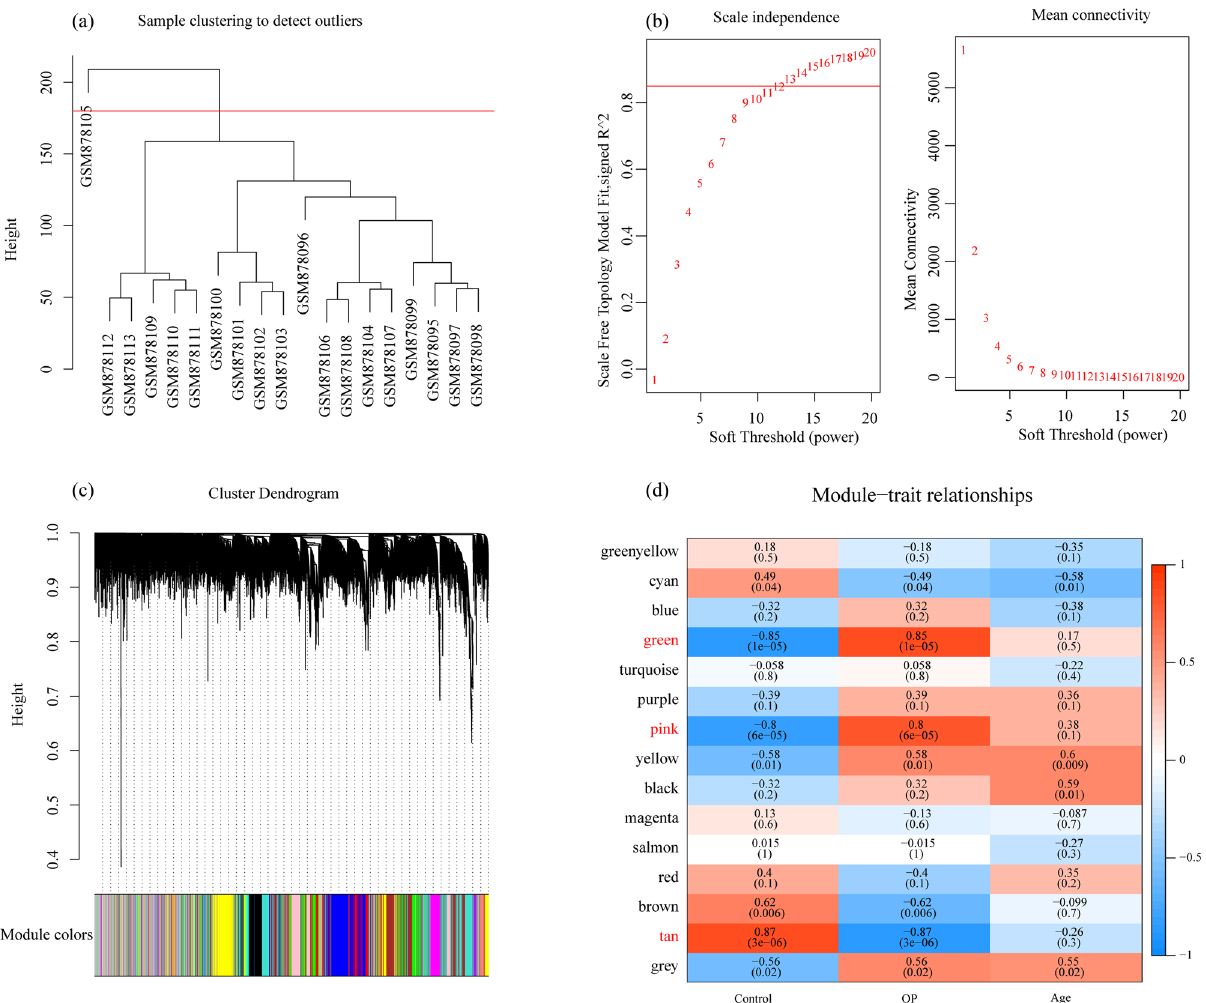
Figure 3: WGCNA: ( a ) cluster analysis of samples, ( b ) analysis of network topology for various soft - thresholding powers, ( c ) gene den - drogram and module colors, and ( d ) correlation results between 15 modules and clinical